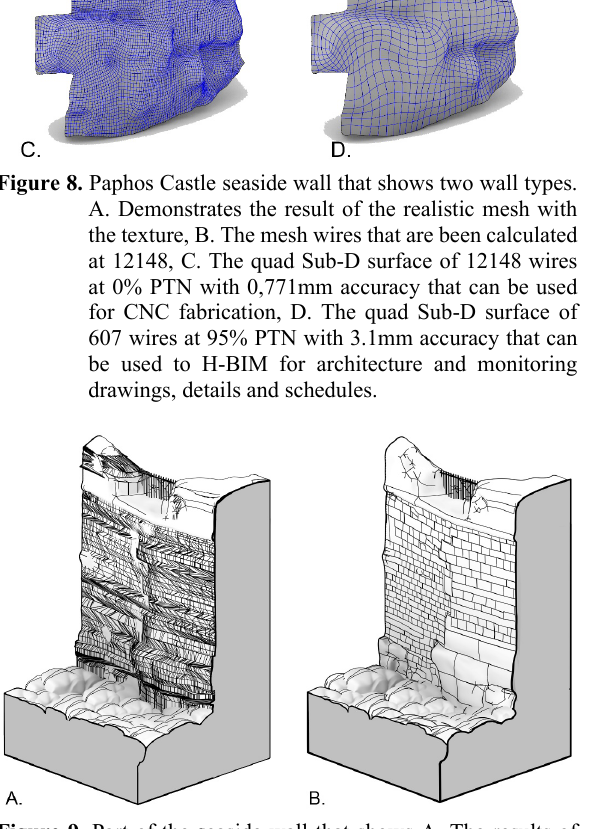
Figure 9. Part of the s easide wall that shows A. The results of standard modelling process using only Revit, B. The results of the suggested adaptive parametric